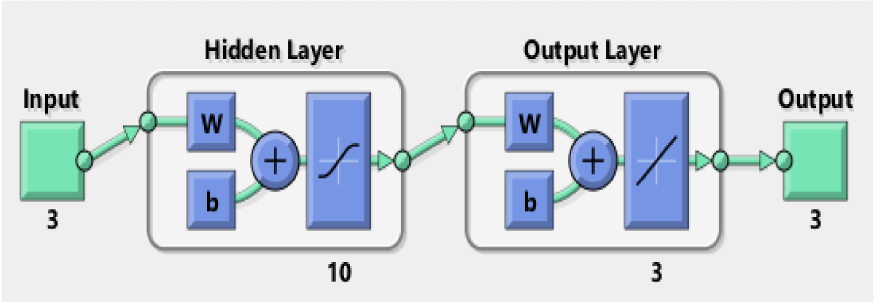
Figure 4. Structure of the artificial neuronal network